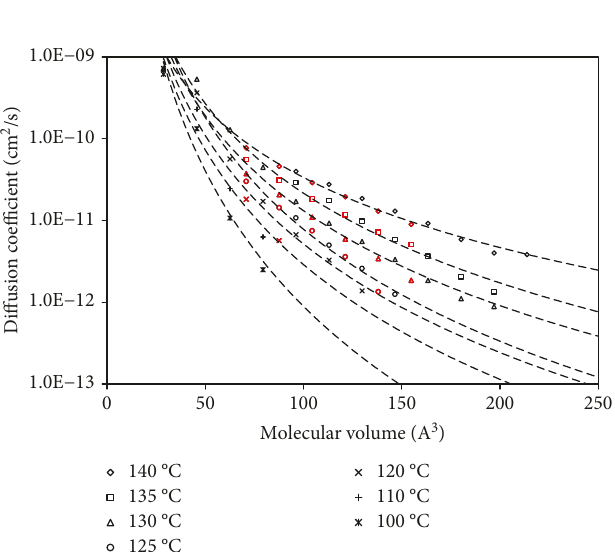
Figure 2: Correlation between the molecular volume V of the permeants and their di ff usion coe ffi cients D 1-alcohols; dashed lines: correlations for n -alkanes and